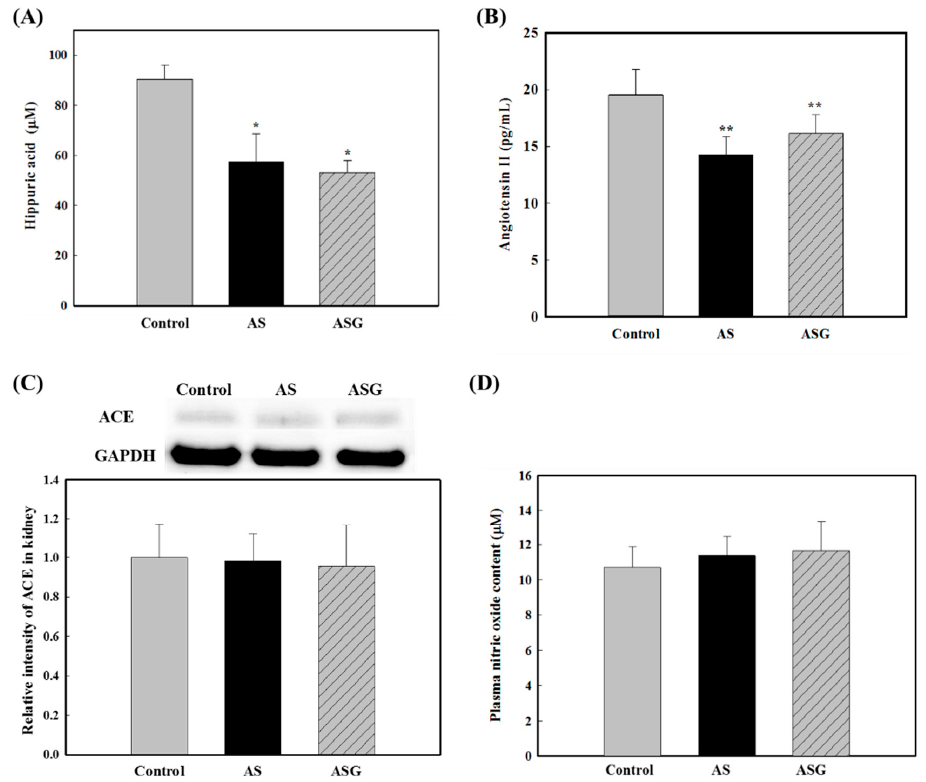
Figure 2. Serum ACE activity ( A ); serum angiotensin II content ( B ); ACE expression level of kidney ( C ); and plasma nitric oxide content ( D ) in rats fed diets of AS and ASG for 6 weeks. Values are expressed as mean ± SD ( n = 8). * p < 0.05 and ** p < 0.01, compared with control (Tukey’s test).